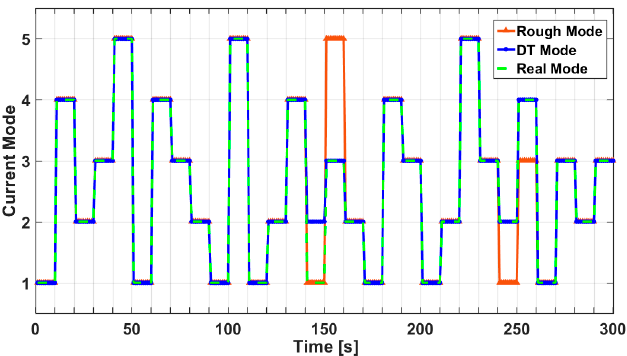
Figure 11. Finite state machine (FSM) + decision tree (DT) classifier pattern monitoring and recognition.